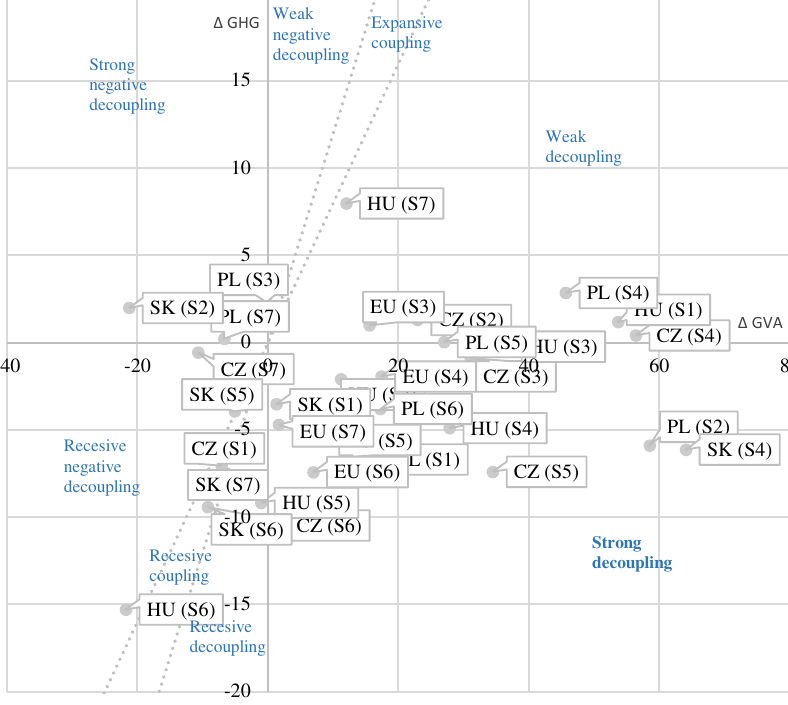
Source: own calculations based on Eurostat